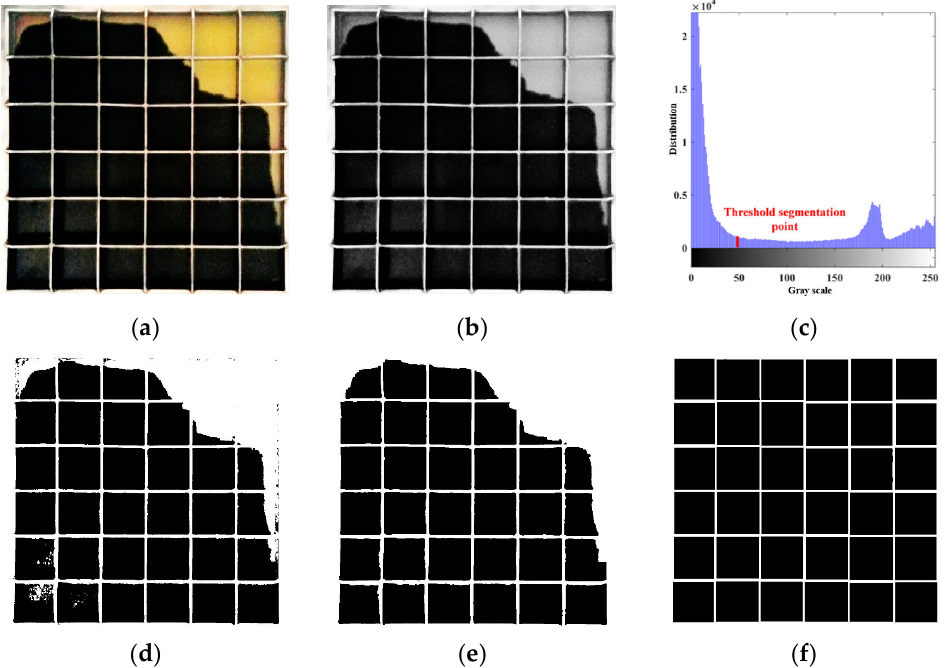
Figure 5. Schematic diagram of image recognition and processing. ( a ) Experimental original image; ( b ) image grayscale recognition; ( c ) image grayscale distribution histogram; ( d ) binary image after threshold segmentation; ( e ) morphologically processed images; ( f ) total area of the excluded grid.